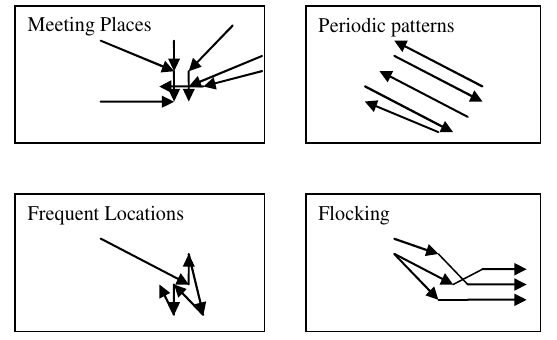
Figure 1. Examples of animal movements, showing schematic movement patterns representing categories, such as ‘meeting places’ and ‘frequent locations’.